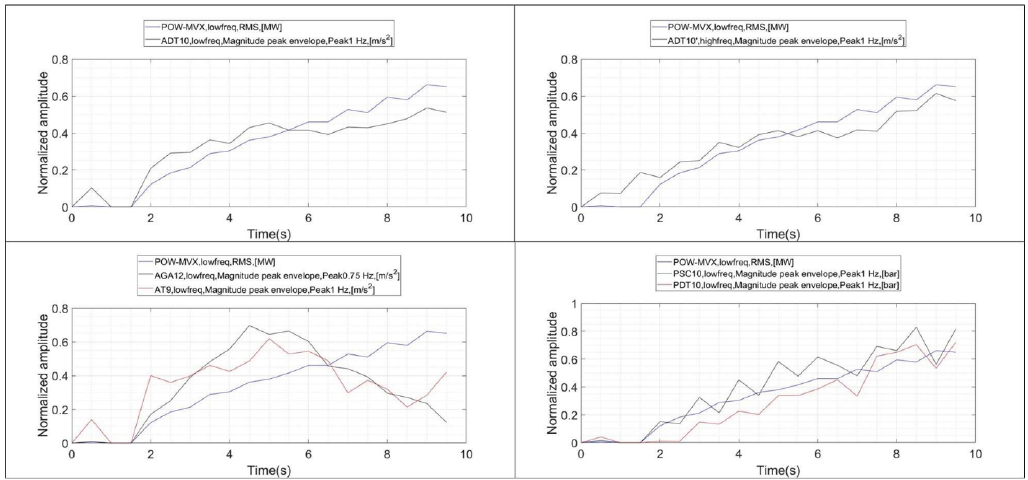
Figure 14. Evolution of the band f rope on the Envelope and RMS of the power signal ( x Envelope − rope vs. x RMS